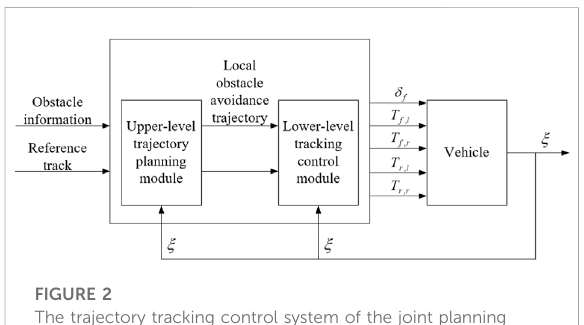
FIGURE 2 The trajectory tracking control system of the joint planning layer. FIGURE 3